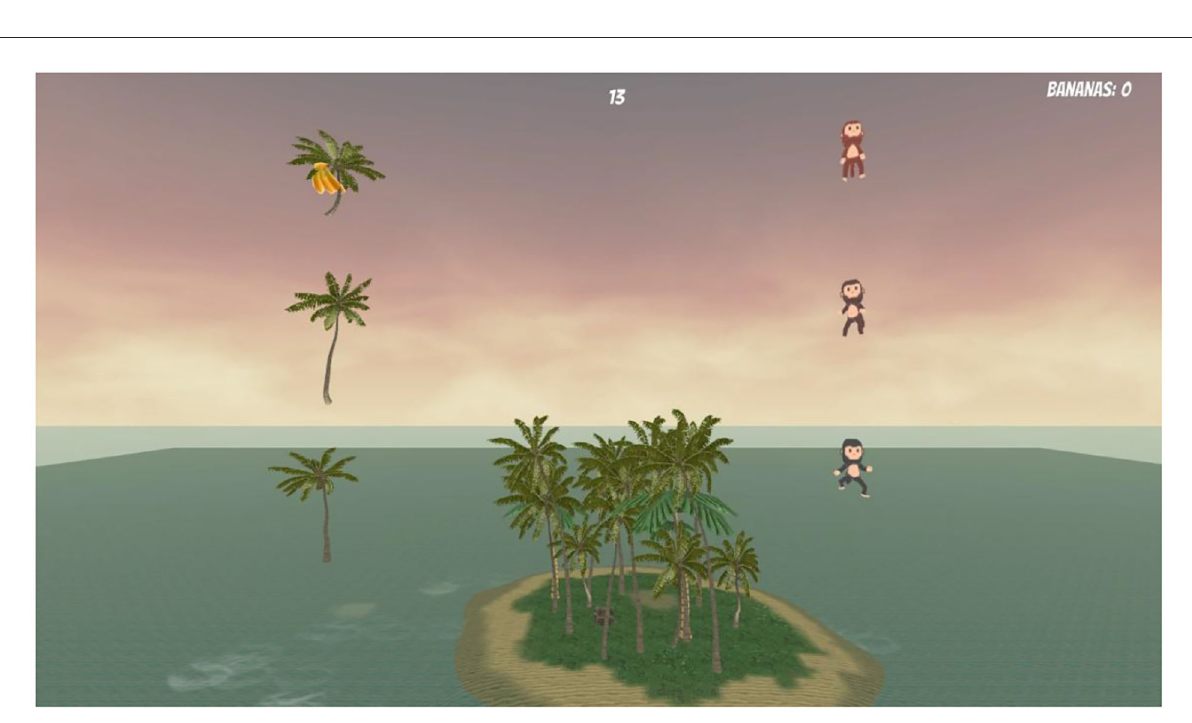
as many gates as they can and collect the coins that appear in the center of each gate if possible. The hand movement should be smooth and as steady as possible to align with the scope of the